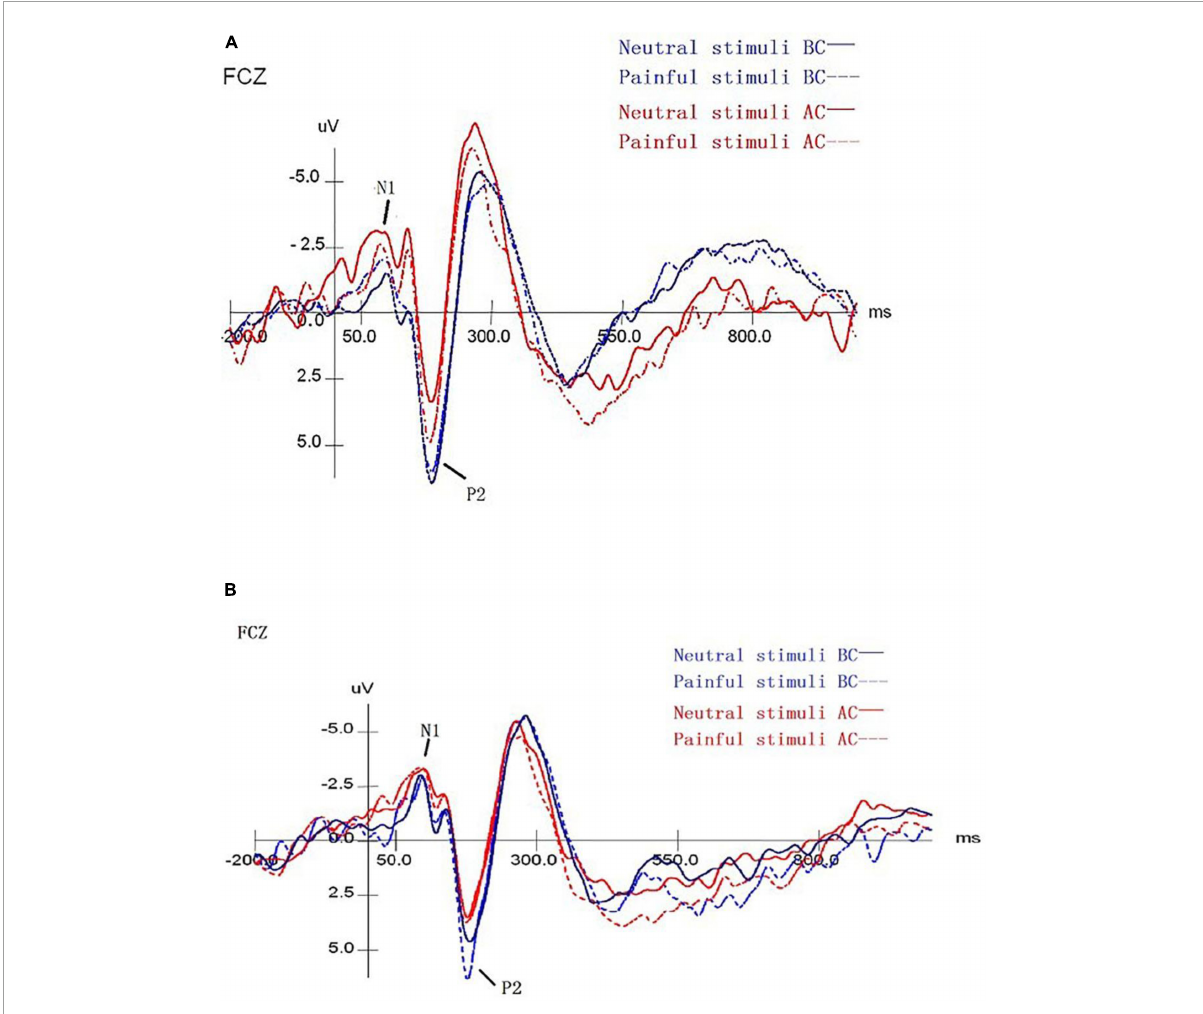
FIGURE2 The mean amplitude results of ERP for pain empathy task. (A) The mean ERP amplitude of the laterality task before and after chemotherapy. (B) The mean ERP amplitude of the painful task before and after chemotherapy. Blue/red lines represent the findings before/after chemotherapy. The solid/dotted lines represent the judgments of neutral/pain stimuli blocks. BC, before chemotherapy; AC, after